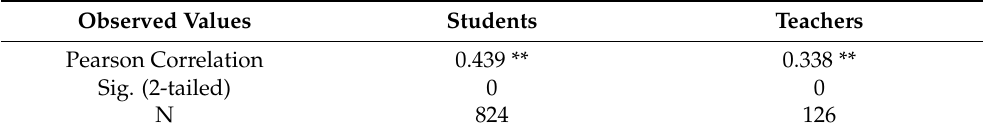
Table 8. Correlations between the average daily duration allocated before and after the pandemic to the preparation/teaching process, after the end of online classes, for students and teachers. Observed Values